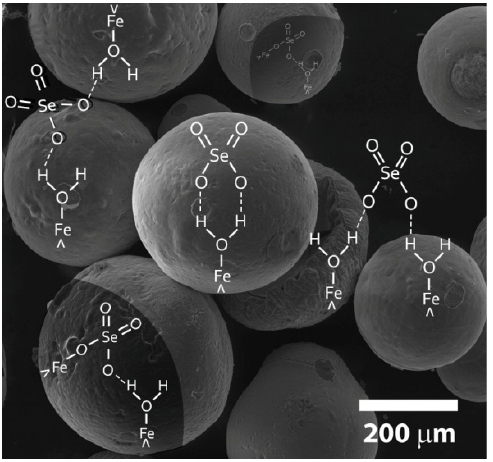
Figure 8. Structures of selenate surface complexes on macroporous polymer impregnated with hydrous iron oxide (ER DETA/FO/FD).